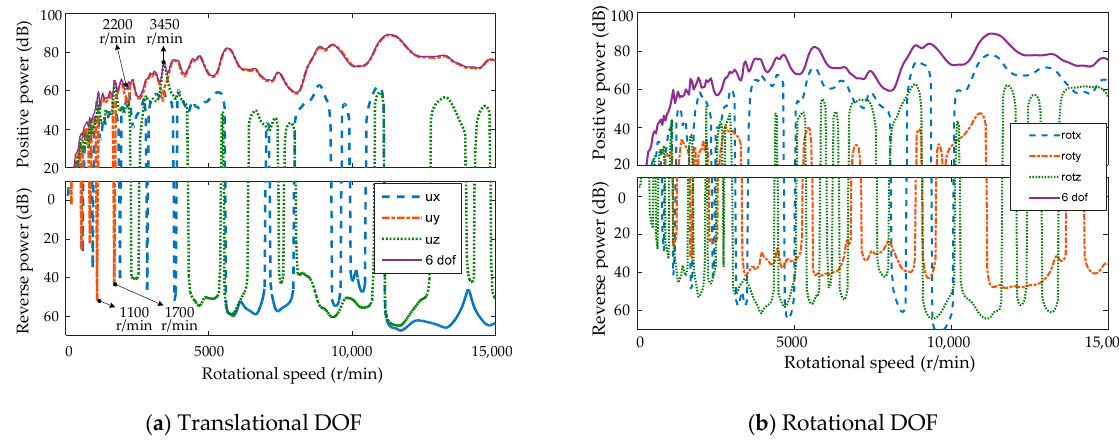
Figure 18. Isolator foundation transmi tt ed power—direction path.